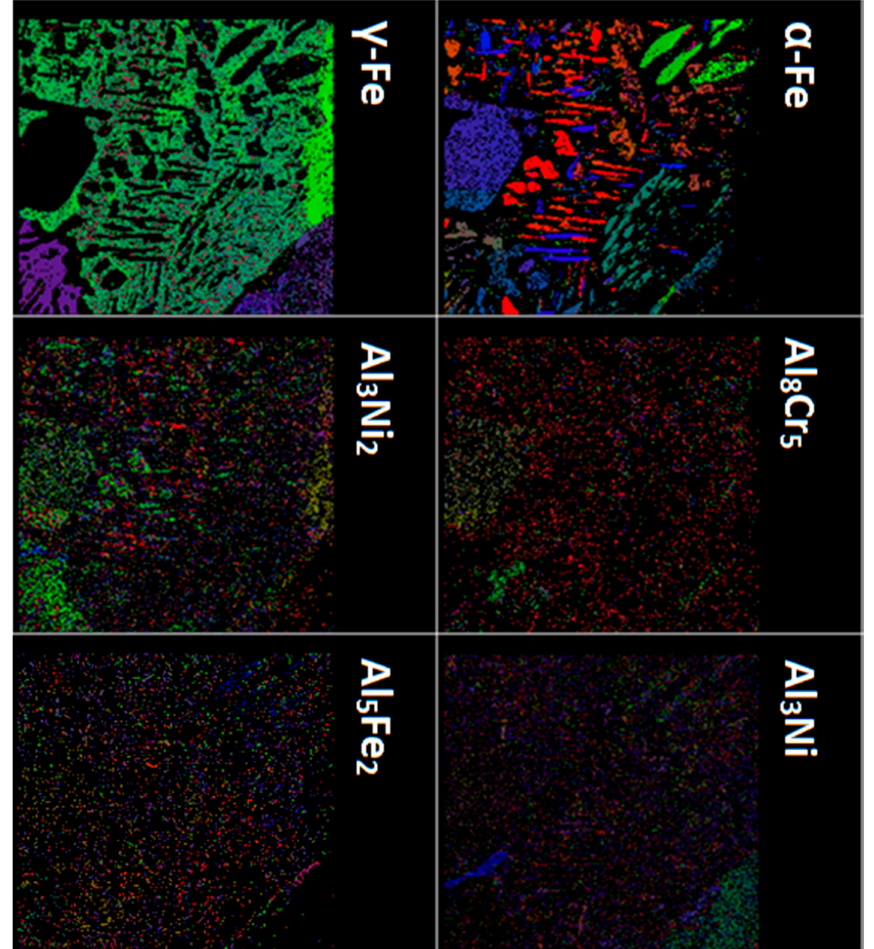
Figure 15. Phases maps obtained through SEM/EBSD measurement reported in Figure